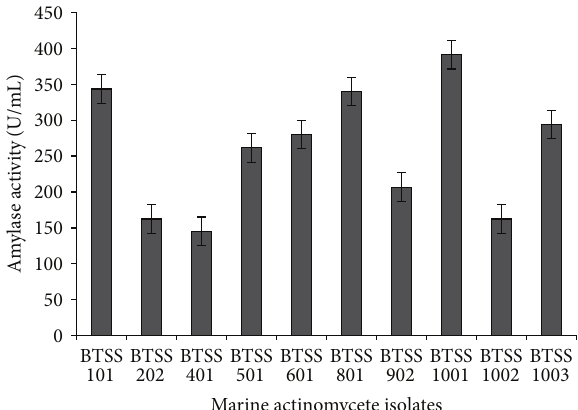
Figure 1: Starch agar plate showing amylase activity with clear zone at the center surrounding the culture of BTSS 1001 isolated from marine sediment of Bay of Bengal. Figure 2: Alkaline amylolytic activity of marine actinomycete isolates under submerged fermentation.